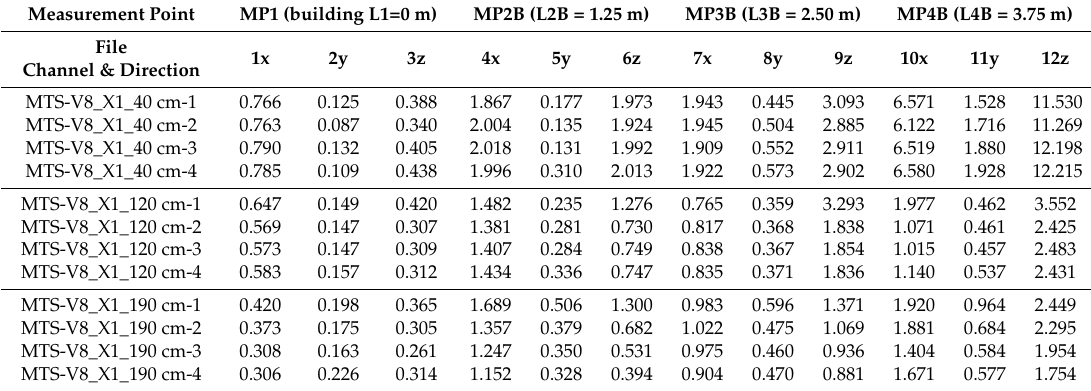
Table 1. Fragmentary summary of the peak component particle acceleration (PPA) value set for the hydraulic compactor type V8 from MTS operating in mode X1 at a distance of Ls = 5 m from the building (stage III), m/s 2.